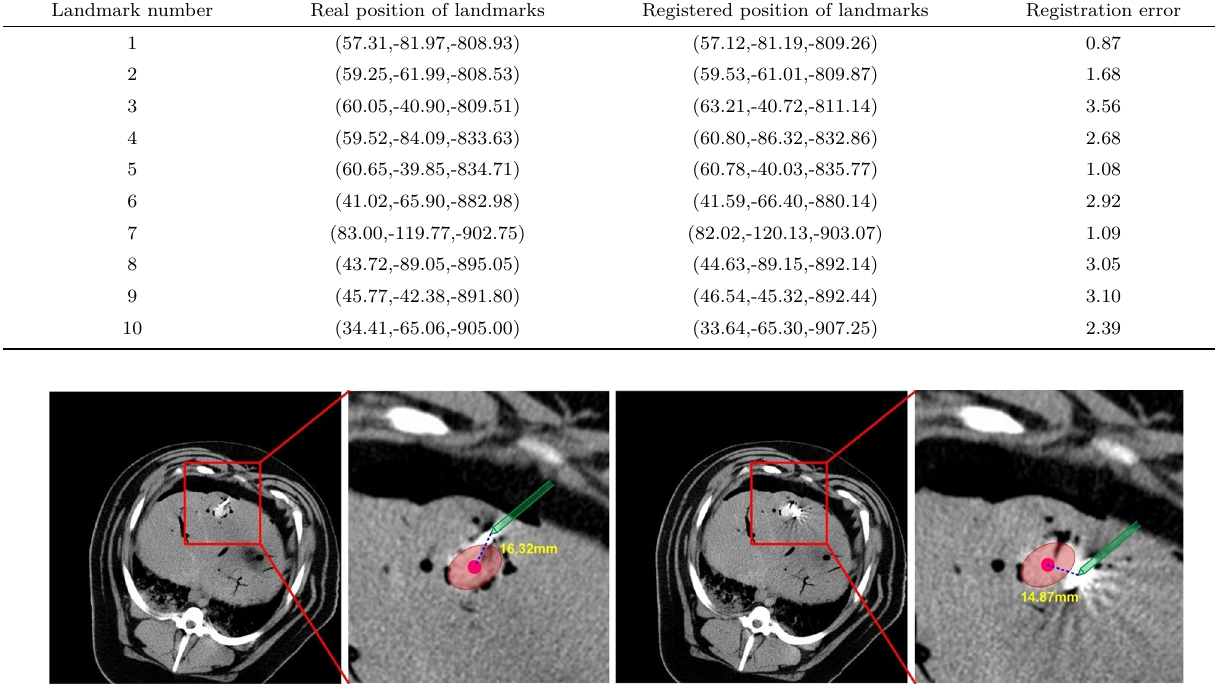
Table 1 Performance statistics of automatic registration